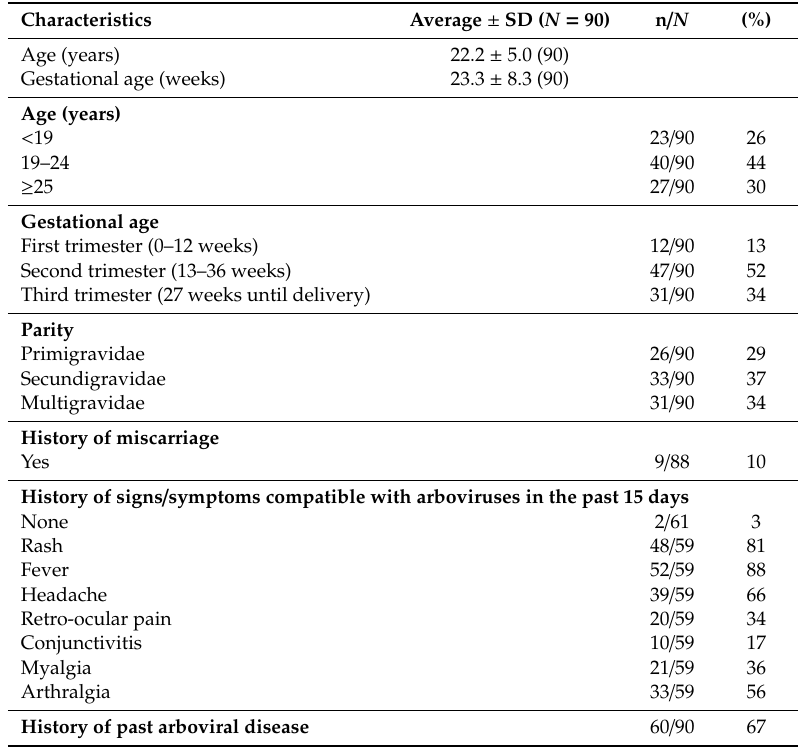
Table 1. Characteristics of 90 pregnant women enrolled in the study in Ceret é , Colombia,